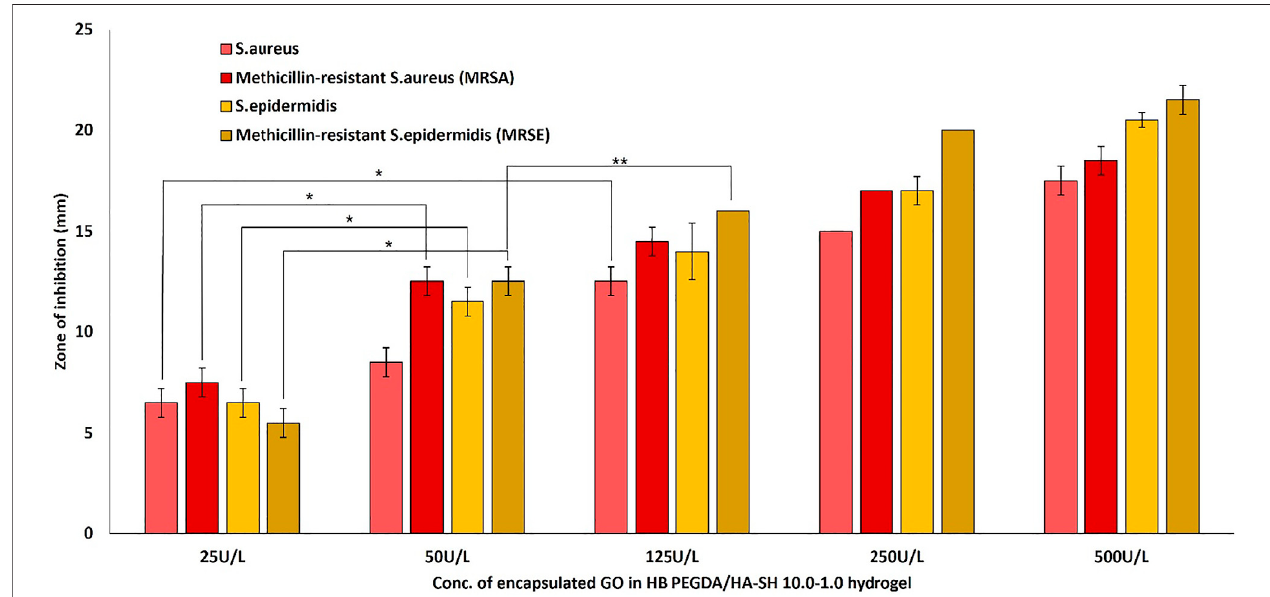
FIGURE 7 | Antibacterial activity of in situ H 2 O 2 -releasing HB PEGDA/HA-SH 10 – 1.0 hydrogels containing different GO activities (25 – 500 U/L) at constant G amount of 2.5 wt% against Gram-positive bacteria S. aureus and S. epidermis and two antibiotic-resistant clinical isolates of MRSA and MRSE. The graph shows the measured inhibition zones (ZOI) of the agar diffusion assays. (* p < 0.01; ** p < 0.05).